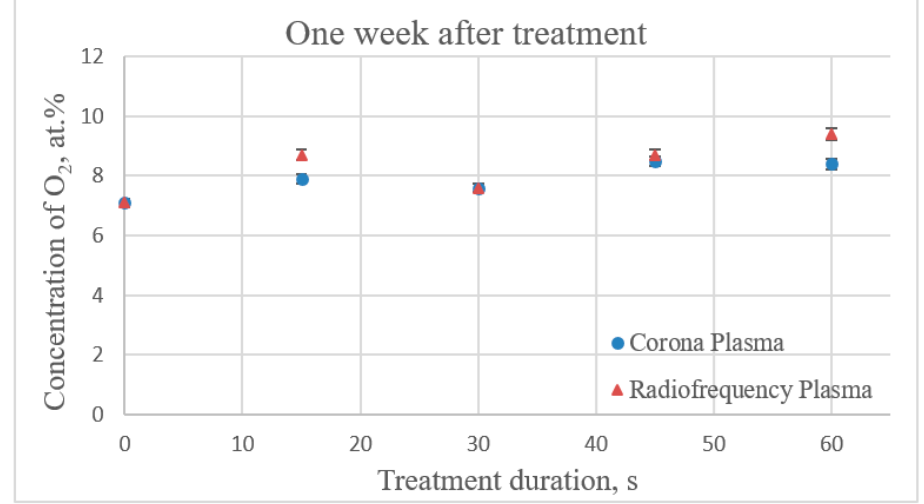
Figure 9. The surface concentration of oxygen (atomic percent) in the surface layer of catheters vs. the time of plasma treatment as established with SEM/EDS spectroscopy one week after the treatment is presented.